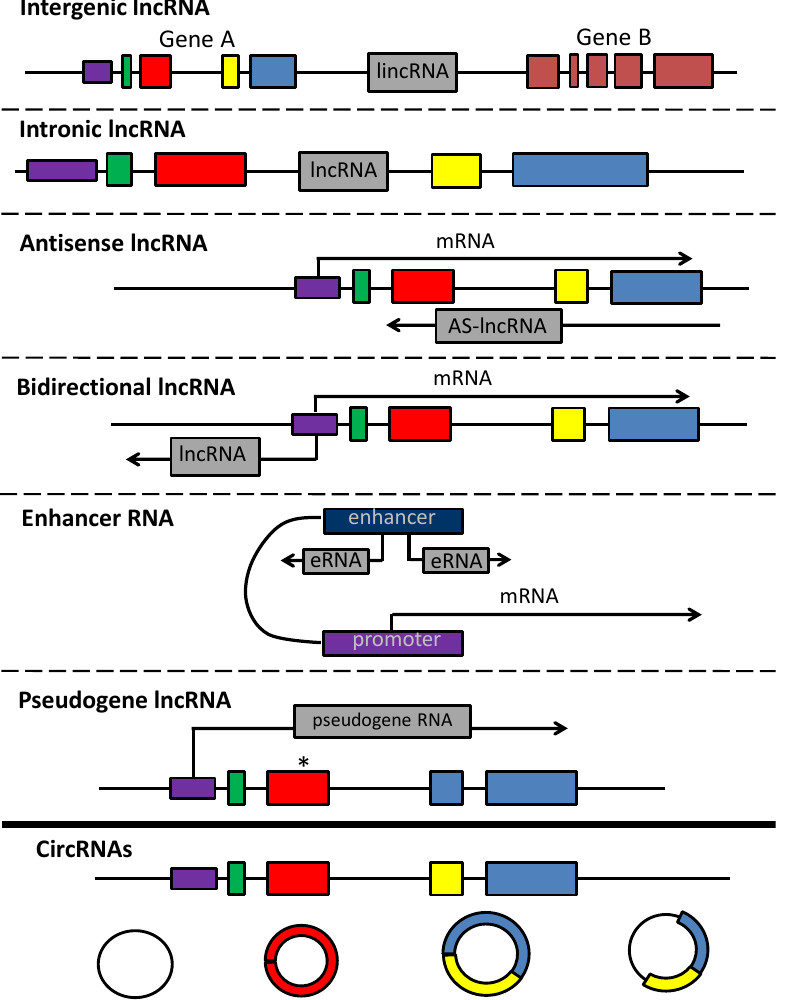
Figure 1. LncRNAs and circRNAs. Gene A comprises 4 exons (in green, red, yellow and blue, respectively). Its promoter is depicted in violet. Intergenic lncRNAs are generated by transcription of sequences between genes; intronic lncRNAs are generated by transcription of intronic regions between exons of a coding gene; antisense lncRNAs are produced by transcription of the antisense DNA strand; bidirectional lncRNAs are produced from the antisense transcription starting from the promoter of the coding gene; enhancer RNAs are derived from enhancer sequences; pseudogene lncRNAs are produced by transcription of genes carrying inactivating mutations (pseudogenes). Mutation is marked by an asterisk. circRNAs are produced from (left to right) intronic sequences, single exons, multiple exons and intronic and exonic sequences.